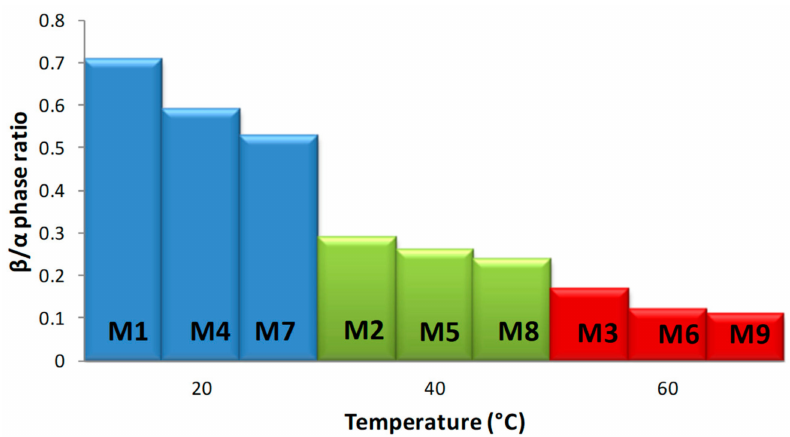
Figure 3. β / α phase ratios of M1–M9